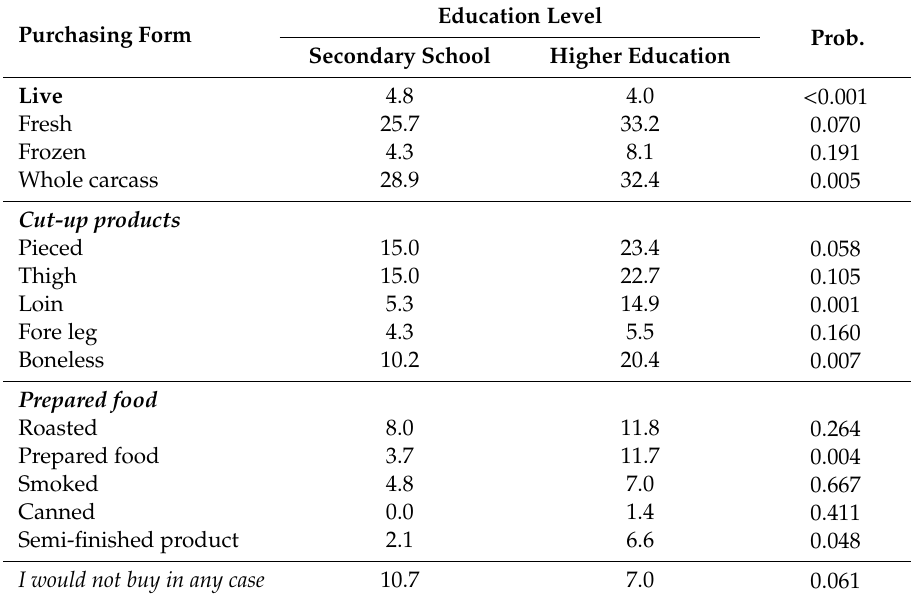
Table 5. E ff ect of purchase forms on the respondents’ attitude (%) depending on the education level with multiple response